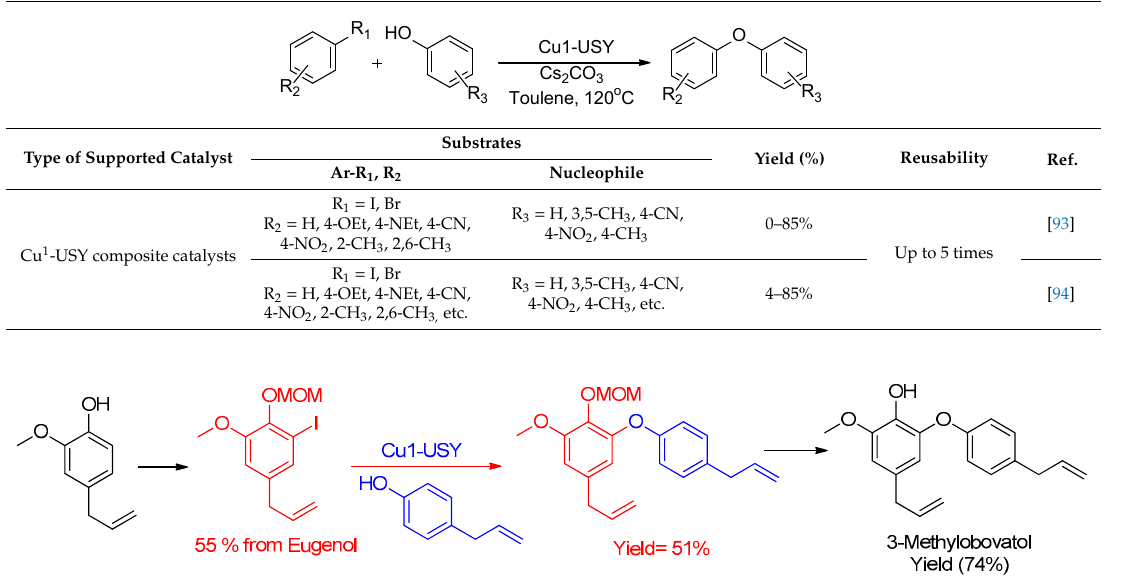
Table 6. Cu 1 -USY composite catalyzed synthesis of biphenyl ethers.